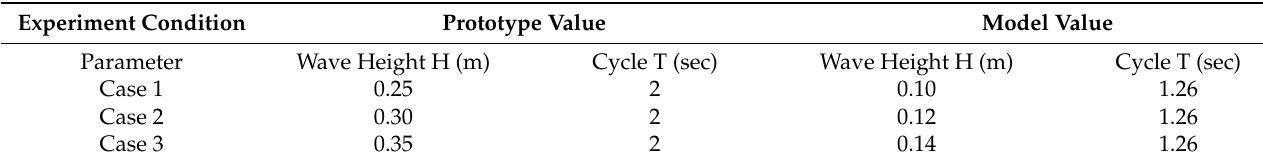
Table 3. Experiment Condition.